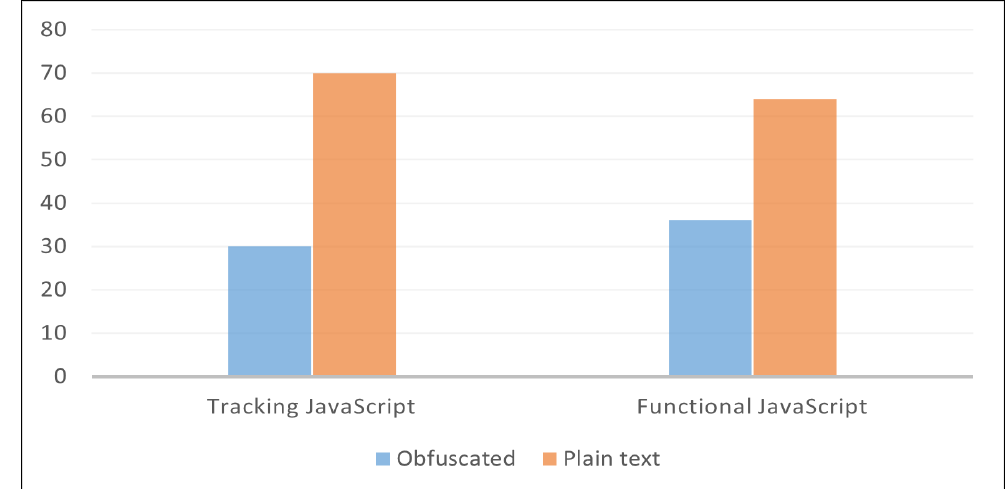
Figure 8. The ratio of obfuscated JavaScript programs presents on the top 50